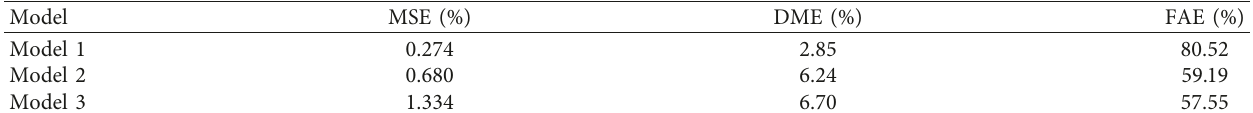
Figure 18: Images for structural beam with (a) no damaged elements and (b) three randomly damaged elements. Table 5: Training result summary for the experimental beam.